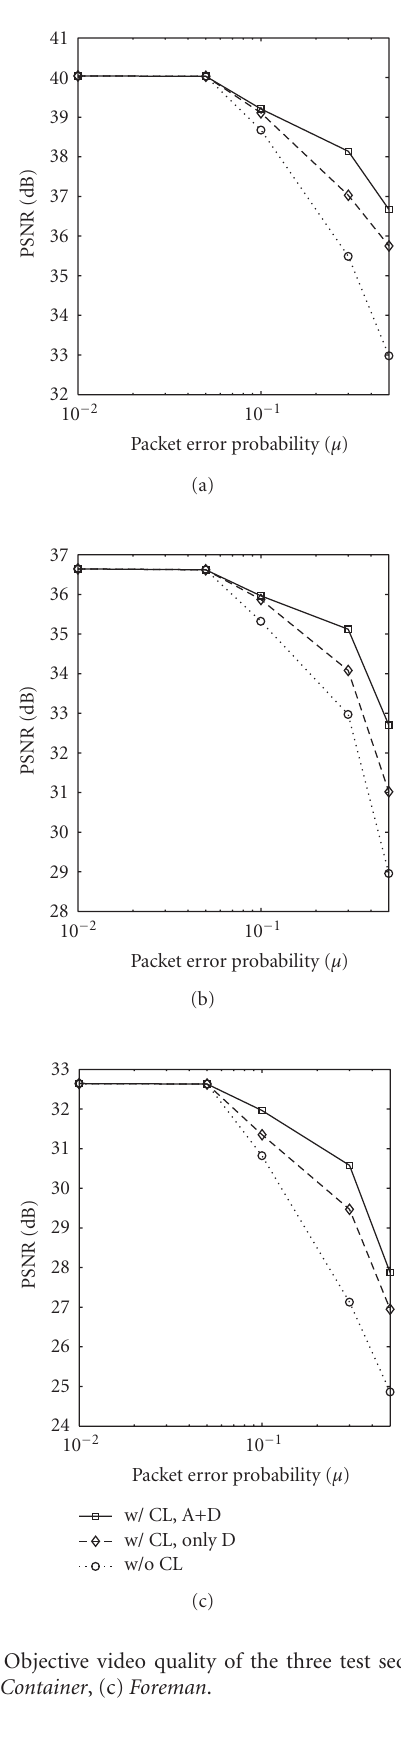
Figure 7: Objective video quality of the three test sequences, (a) Akiyo , (b) Container , (c) Foreman